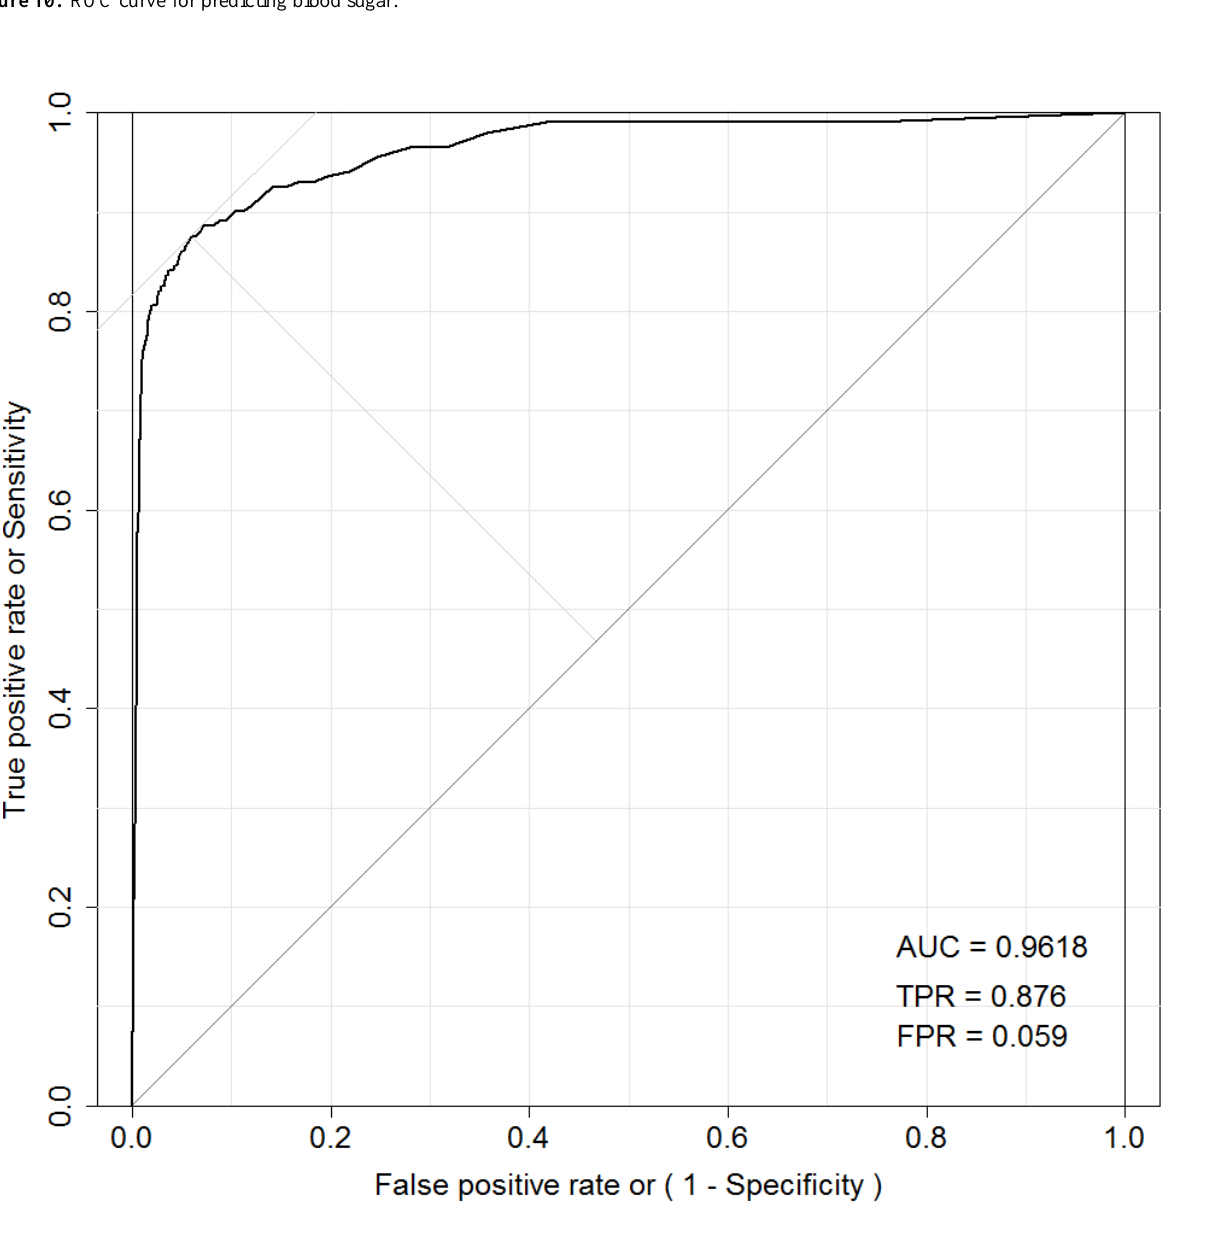
Figure 10. ROC curve for predicting blood